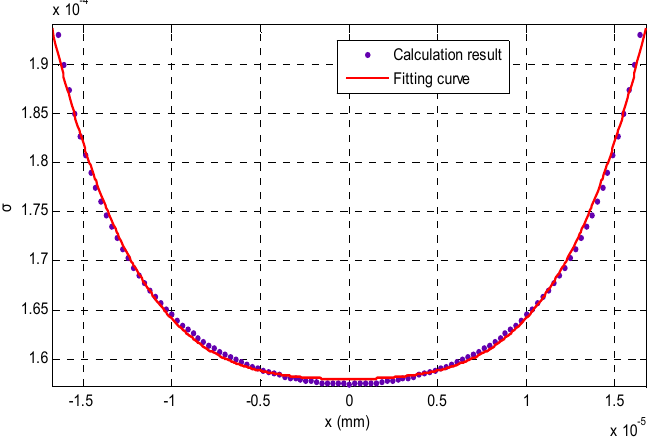
Figure 5. The blurring imaging model fitted by a 4th order polynomial curve.